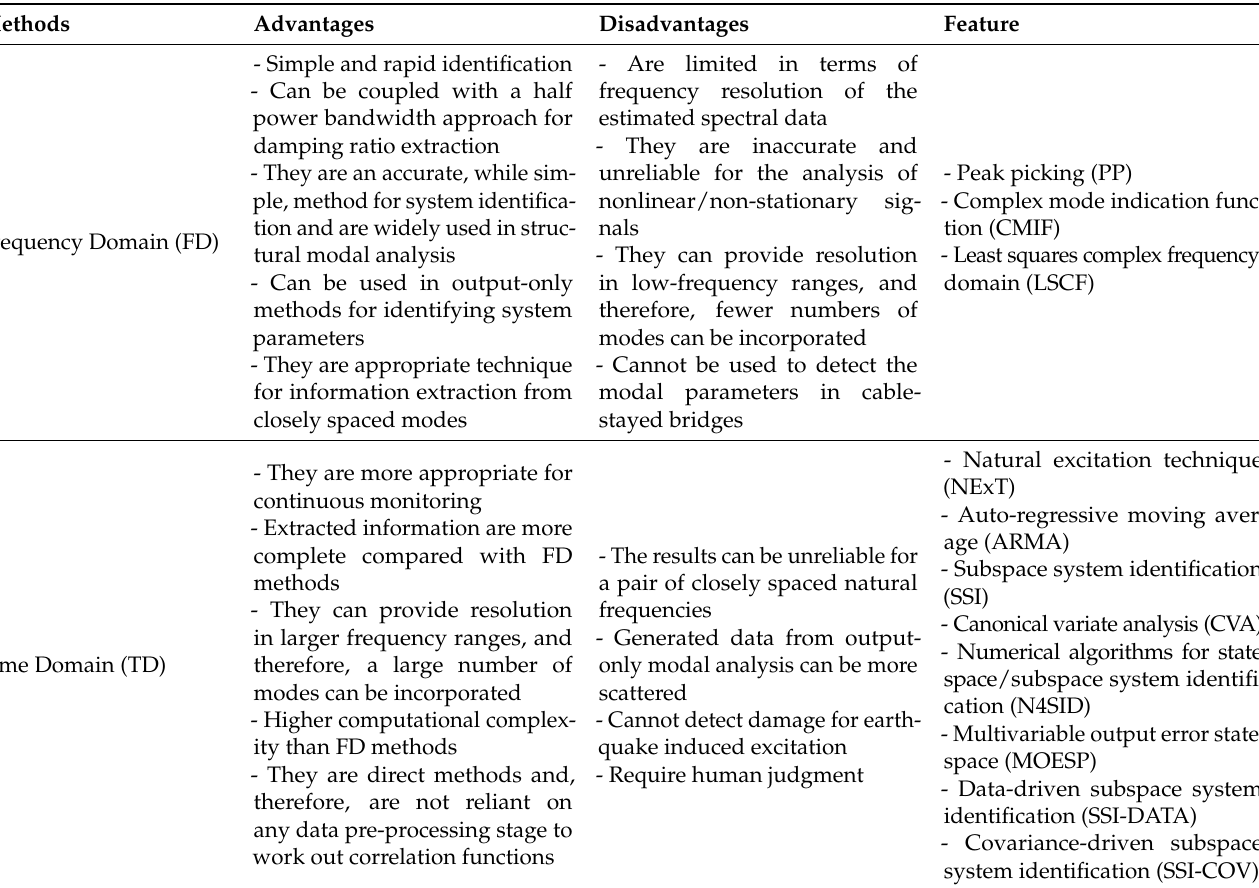
Table 17. The advantages and disadvantages of frequency domain versus time domain damage- detection